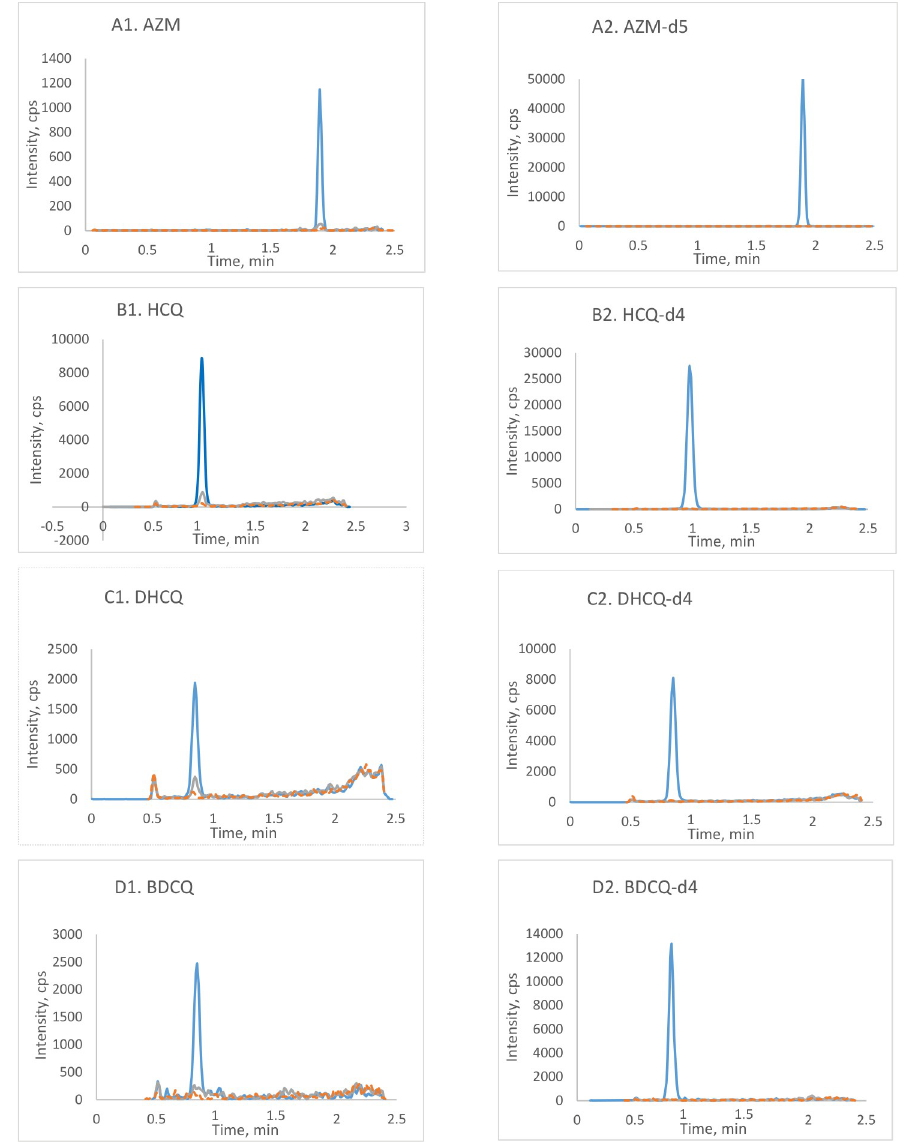
Fig 2. Representative chromatograms of blank (red dash line), the LLOQ (blue solid line) and double blank samples following ULOQ (grey solid line). Blank sample was processed with IS, double blank sample was processed without